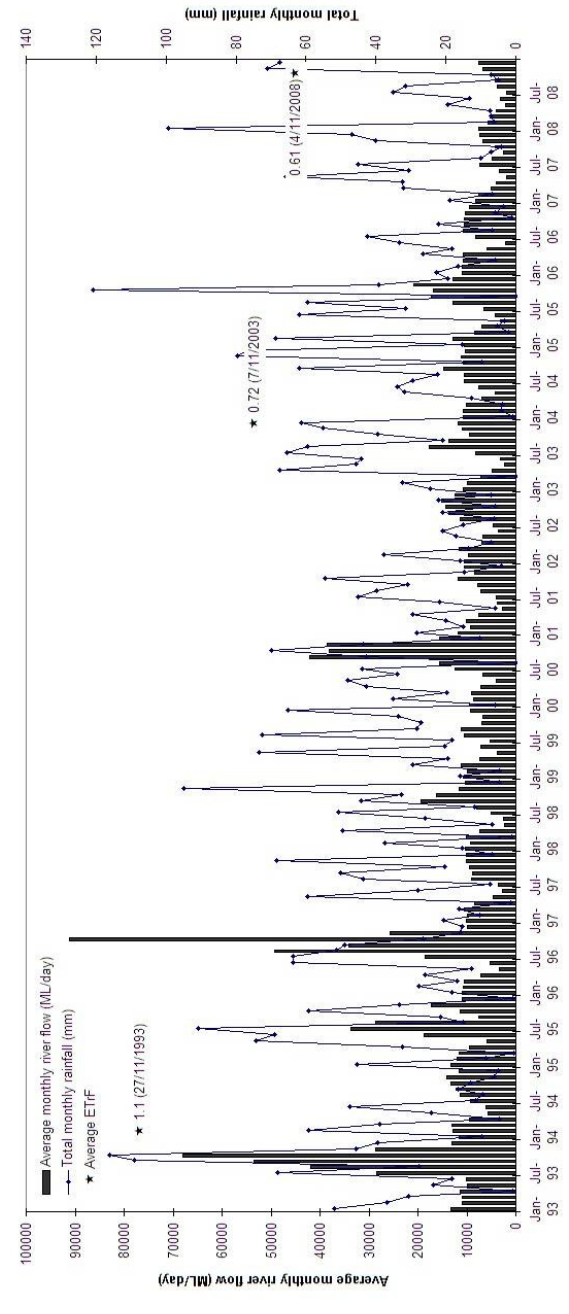
Figure 4. Monthly mean river flow, monthly total rainfall and average ETrF values for the Barmah Forest between 1993 and